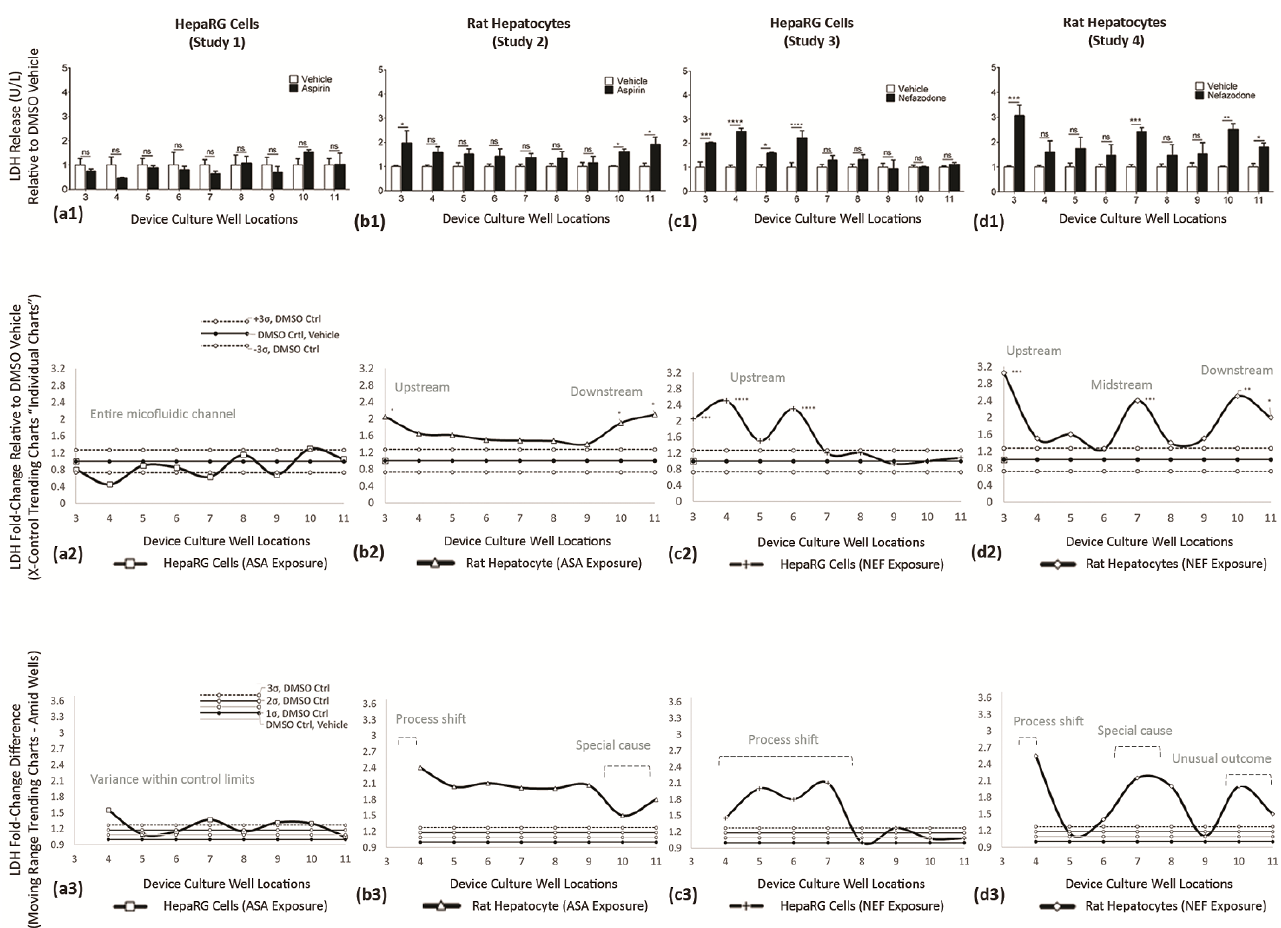
Figure 10. LDH release across multiwell cultures on Day 7. LDH activity shown as fold